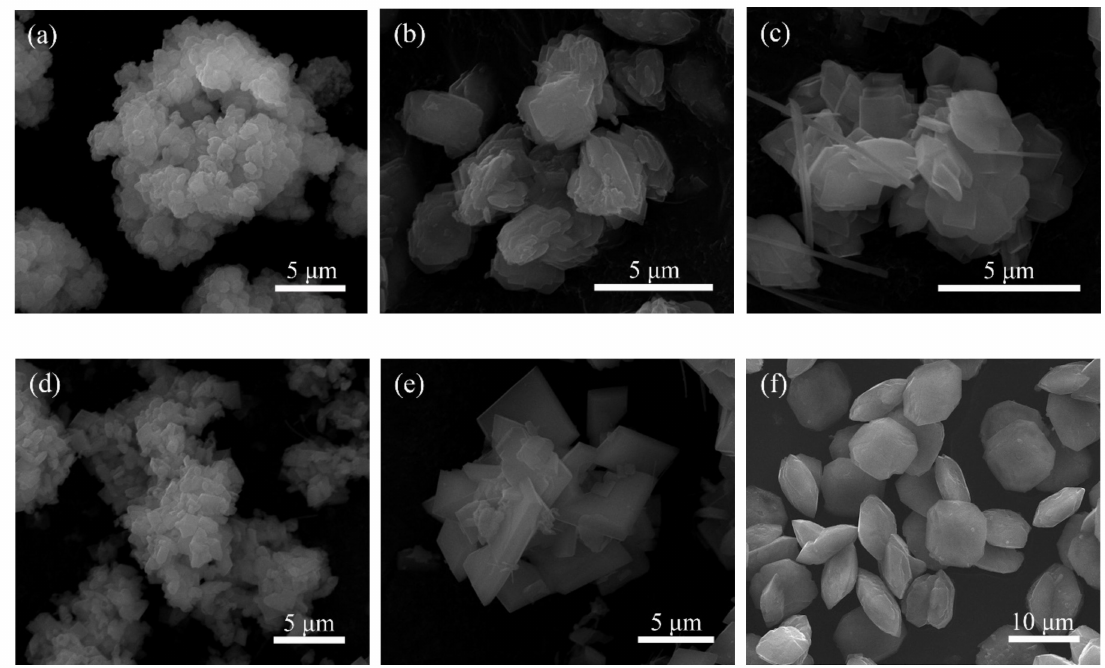
Figure 2. SEM images of the hydrothermal products obtained from different temperatures and NaOH concentrations: ( a ) 150 ◦ C, 10 mol/L; ( b ) 180 ◦ C, 10 mol/L; ( c ) 210 ◦ C, 14.3 mol/L; ( d ) 240 ◦ C, 6 mol/L; ( e ) 240 ◦ C, 10 mol/L; ( f ) 240 ◦ C, 14.3 mol/L.